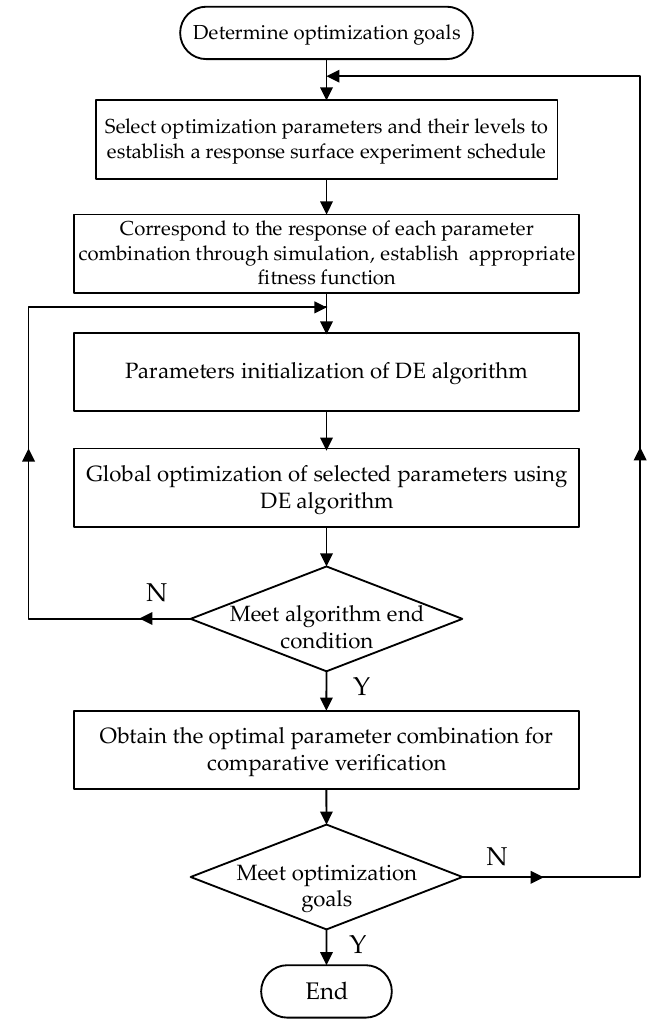
Figure 6. Flow chart of the DE algorithm for optimal parameters.